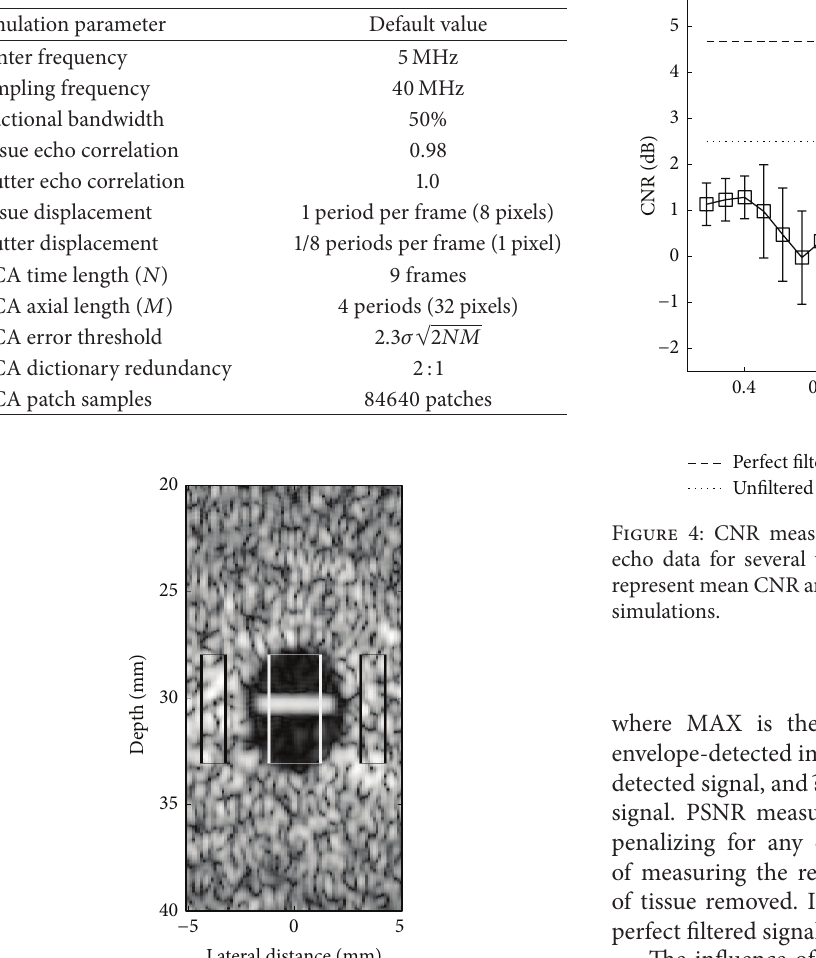
Table 1: Default Field II simulation parameters.